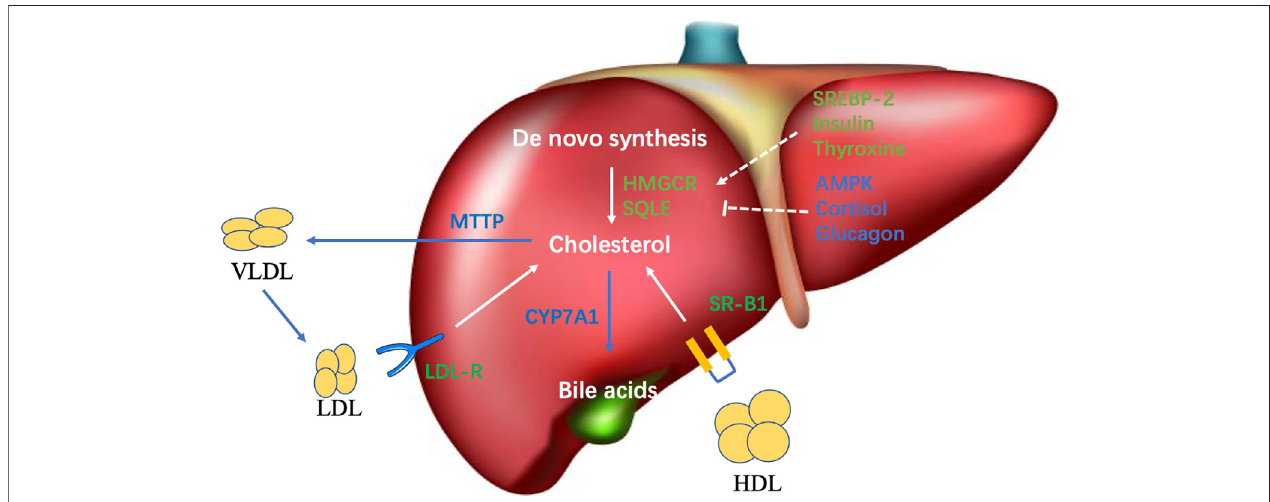
FIGURE 1 | Overview of cholesterol metabolism in the liver. The primary sources of hepatic cholesterol are de novo synthesized and circulating cholesterol carried by apoB-containing lipoprotein particles. Output pathways of hepatic cholesterol mainly comprise VLDL secretion and bile acid synthesis.